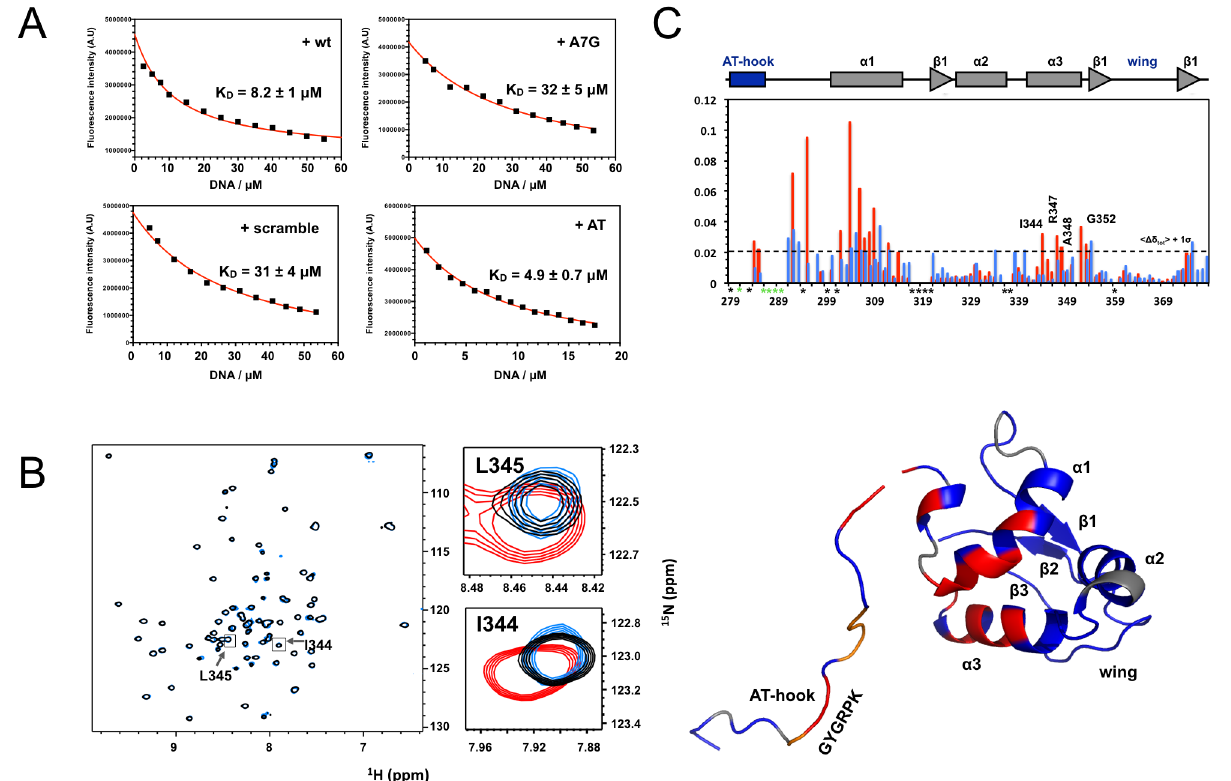
Fig 4. Details of DNA recognition by Ms1. A: Fluorescence titrations of Ms1 270 – 375 with a double strand oligonucleotide representing the motif identified in the SELEX procedure (wt), a version in which the central A of the motif is replaced by a G (A7G), the scrambled version of wt (scrambled) and a version with additional AT base pairs (AT). Data points are shown in black, the fitting result in red. B: A full view and selected parts of 15 N- 1 H HSQC spectra of Ms1 270 – 375 without (black), with the addition of the wt oligo (red) and the A7G mutant oligo (blue) at a 2:1 ratio. Zoomed views are shown for two residues from helix 3. C: plot of chemical shift perturbations of NMR interaction experiments of Ms1 270 – 375 with the wt (red) and A7G oligo (blue) against the protein sequence. The dotted horizontal line represents the 1 * σ noise level. Amino acids for which assignments are missing are labelled with black stars, those that disappear in the titration are labelled with green stars. D: mapping of residues with significant chemical shift perturbations on the surface of the structure of ABD2 (red: chemical sift perturbatios > 1 * σ , orange: residues that disappear in the titration, grey: reidues for which assignments are missing). For residues 294 – 375 our experimental ABD2 structure is used to which residues 270 – 294 were added based on a homology model manually created using the known structure of an AT-hook (PDB ID 2EZD).